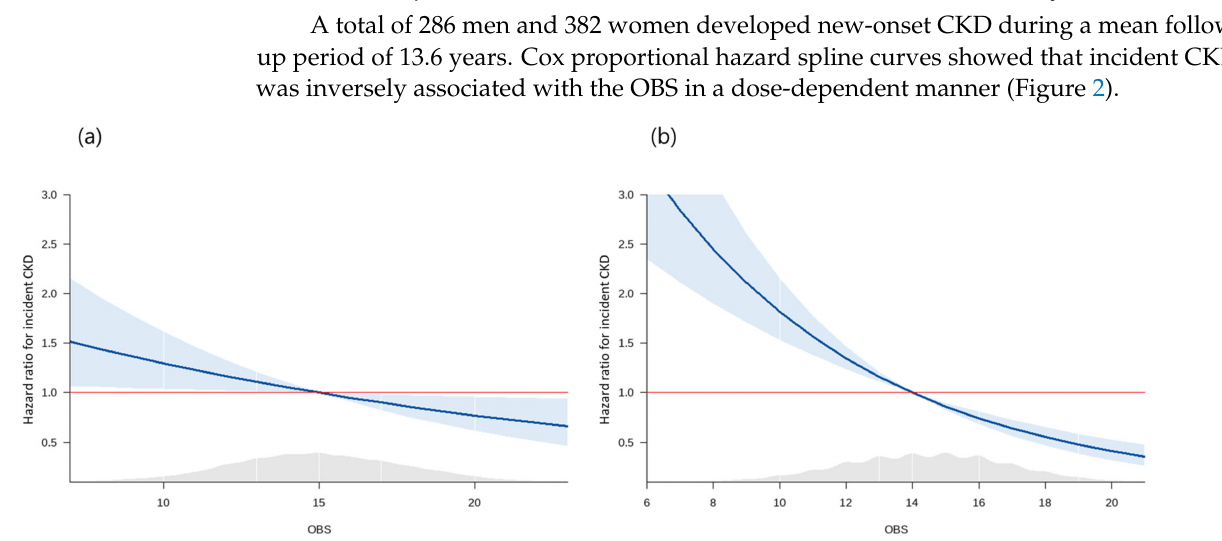
Figure 2. Spline curves for the Cox proportional hazard model of incident CKD according to OBS in ( a ) men and ( b ) women. Abbreviations: CKD, chronic kidney disease; OBS, oxidative balance